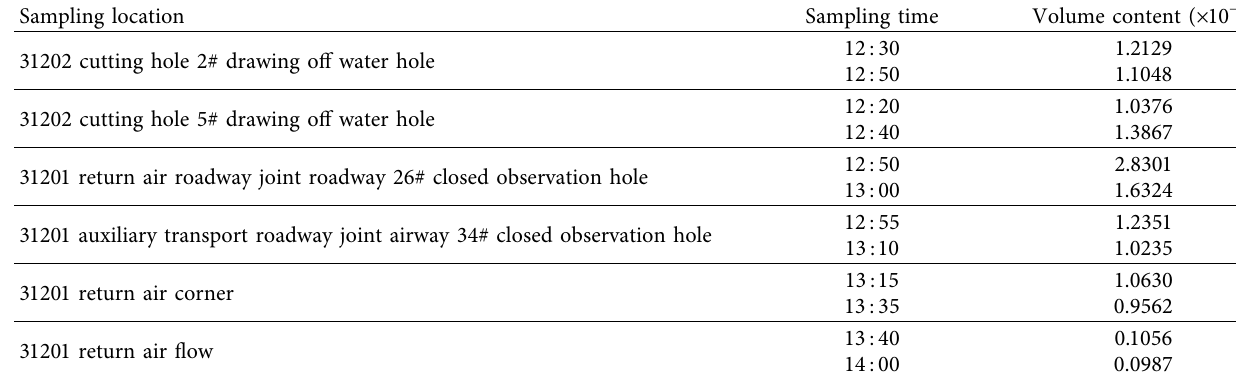
Figure 7: Temperature anomaly. (a) Radon surface concentration. (b) Anomalies of Table 2: SF 6 gas sample analysis results.